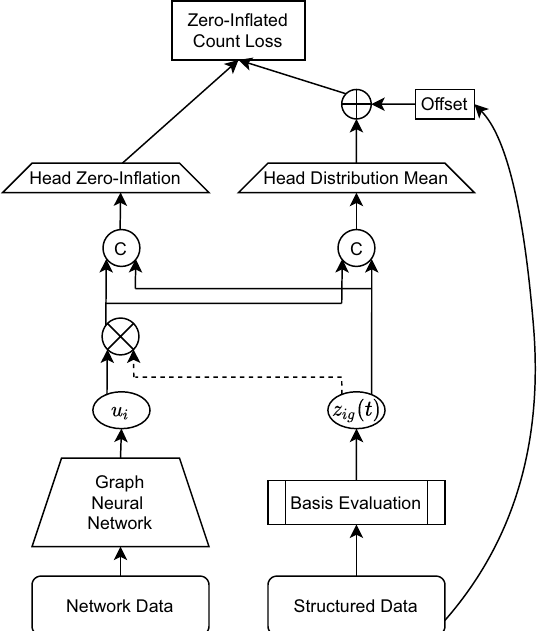
Figure 2. Network architecture of the proposed model. The mobility data is fed into a GNN on the bottom left to learn latent features u i . On the bottom right side, the structured data is transformed using basis evaluation. Using the orthogonalization the learned effects u i are projected onto the orthogonal complement of selected parts of the basis evaluated structured features. Both parts are combined using a concatenation and fed into both a network head that learns the zero-inflation as well as a network head to learn the distribution’s mean. After adding an offset to the mean, both parts are finally combined in a distributional layer that learns the zero- inflated count distribution based on the corresponding